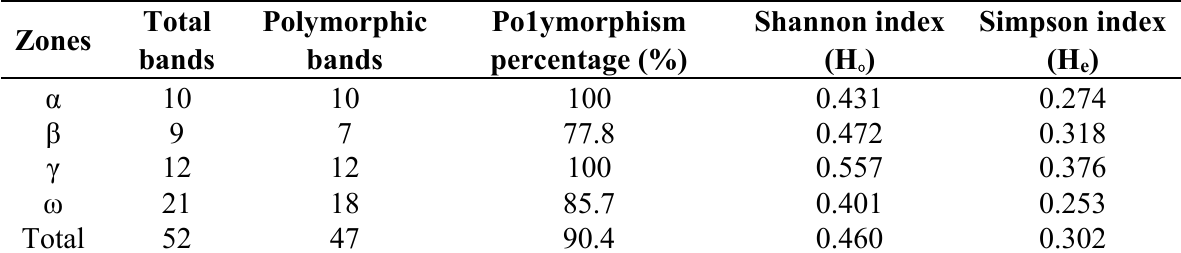
Table 2. The genetic diversity indexes among 86 accessions of E. sibiricus